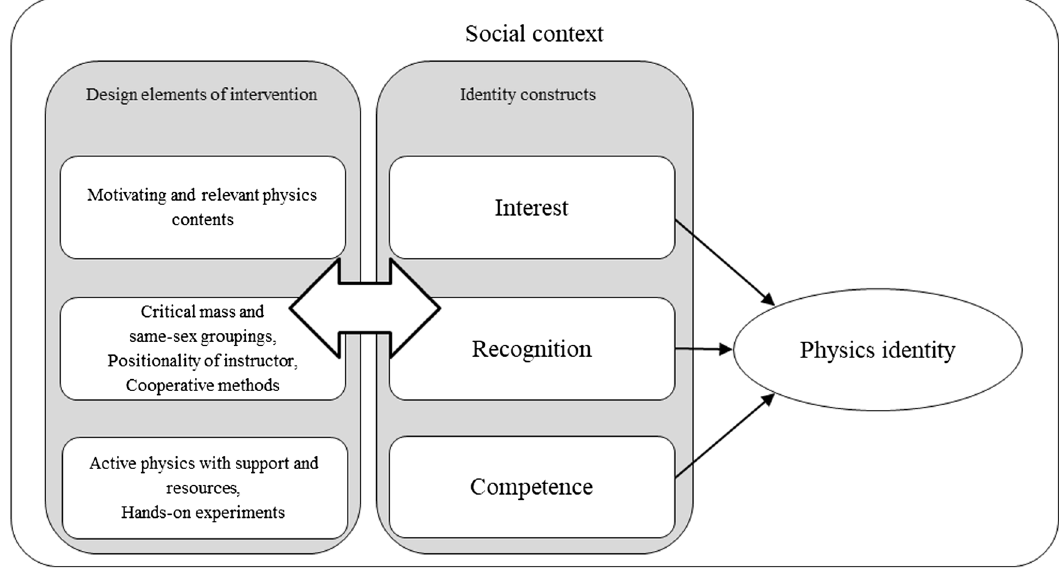
FIG. 2. Design elements of the